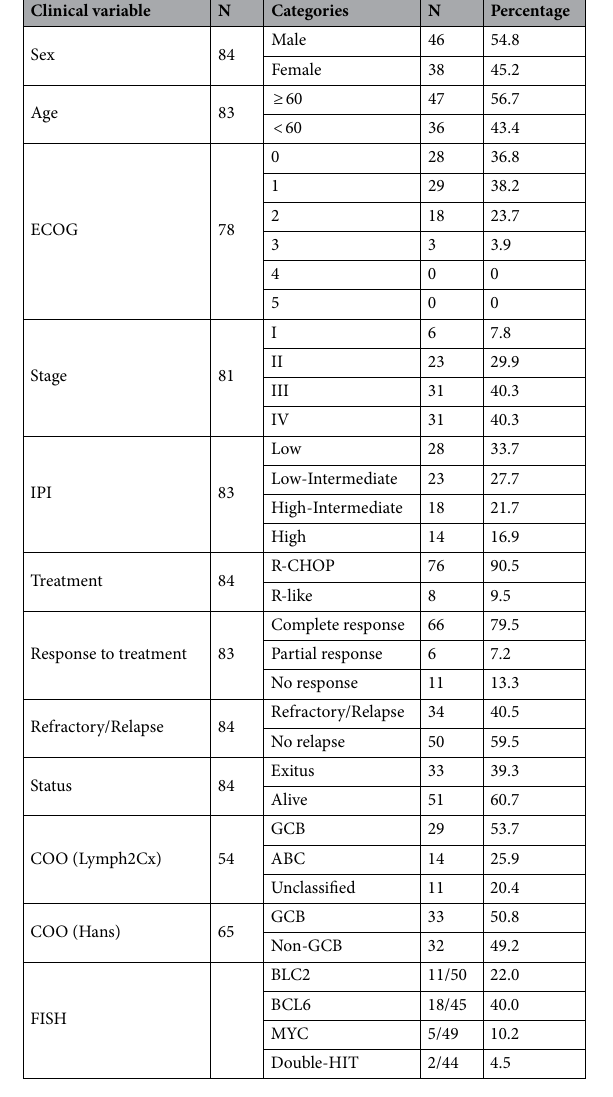
Table 1. Summary of clinical data of the Puerta de Hierro (PdH) cohort. International Prognostic Index (IPI), rituximab, cyclophosphamide, doxorubicin, vincristine, and prednisone (R-CHOP), rituximab-like